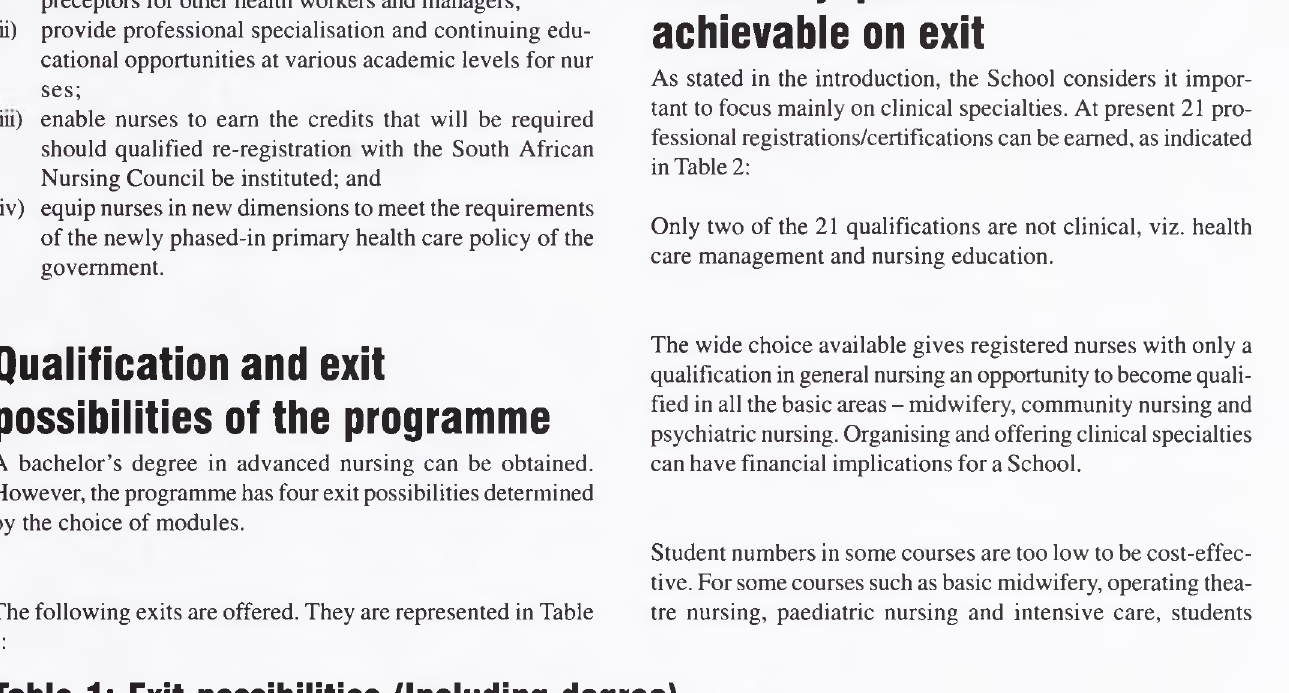
Table 1: Exit possibilities (Including